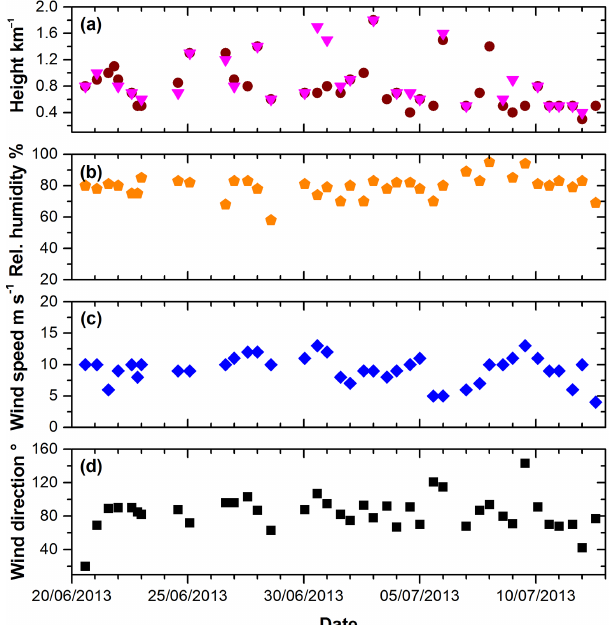
Figure 3. (a) CMBL height derived from radiosonde measure- ments (brown dots) and lidar measurements (magenta rectangles), (b) mean relative humidity within the CMBL derived from ra- diosonde measurements, (c) mean wind speed in the CMBL mea- sured with radiosonde, and (d) mean wind direction in the CMBL derived from radiosonde measurements.